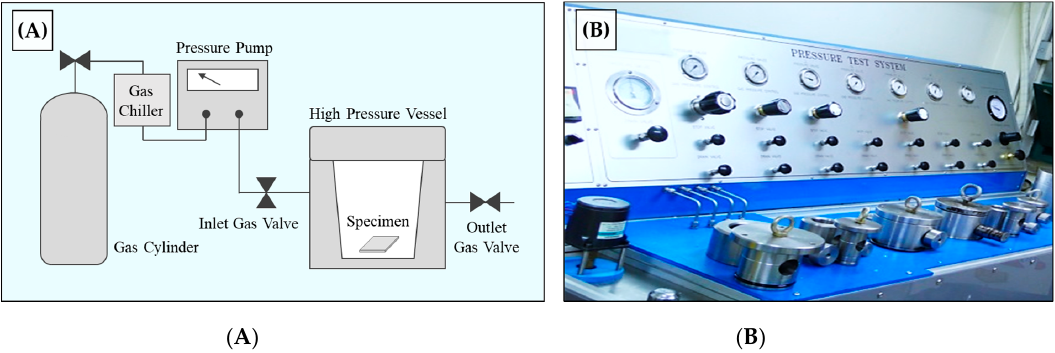
Figure 3. ( A ) Schematic diagram of the microcellular foaming process in the batch process; ( B ) microcellular foam batch process equipment used in this study.